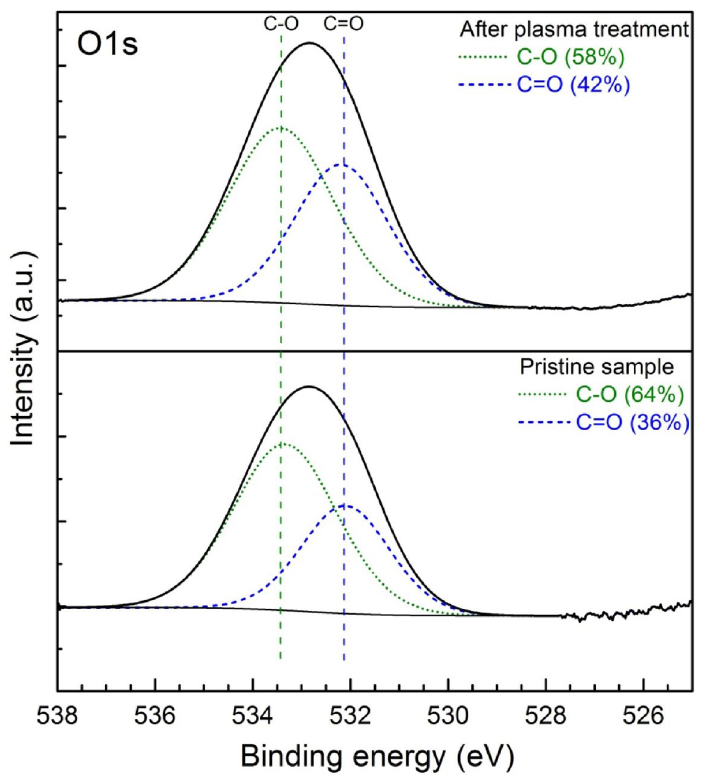
Figure 13. XPS analysis of O1s peak of PMMA polymer before and after plasma treatment measured in a binding energy interval of 538–527 eV. Argon flow rate 20 NL/min. Microwave power 460